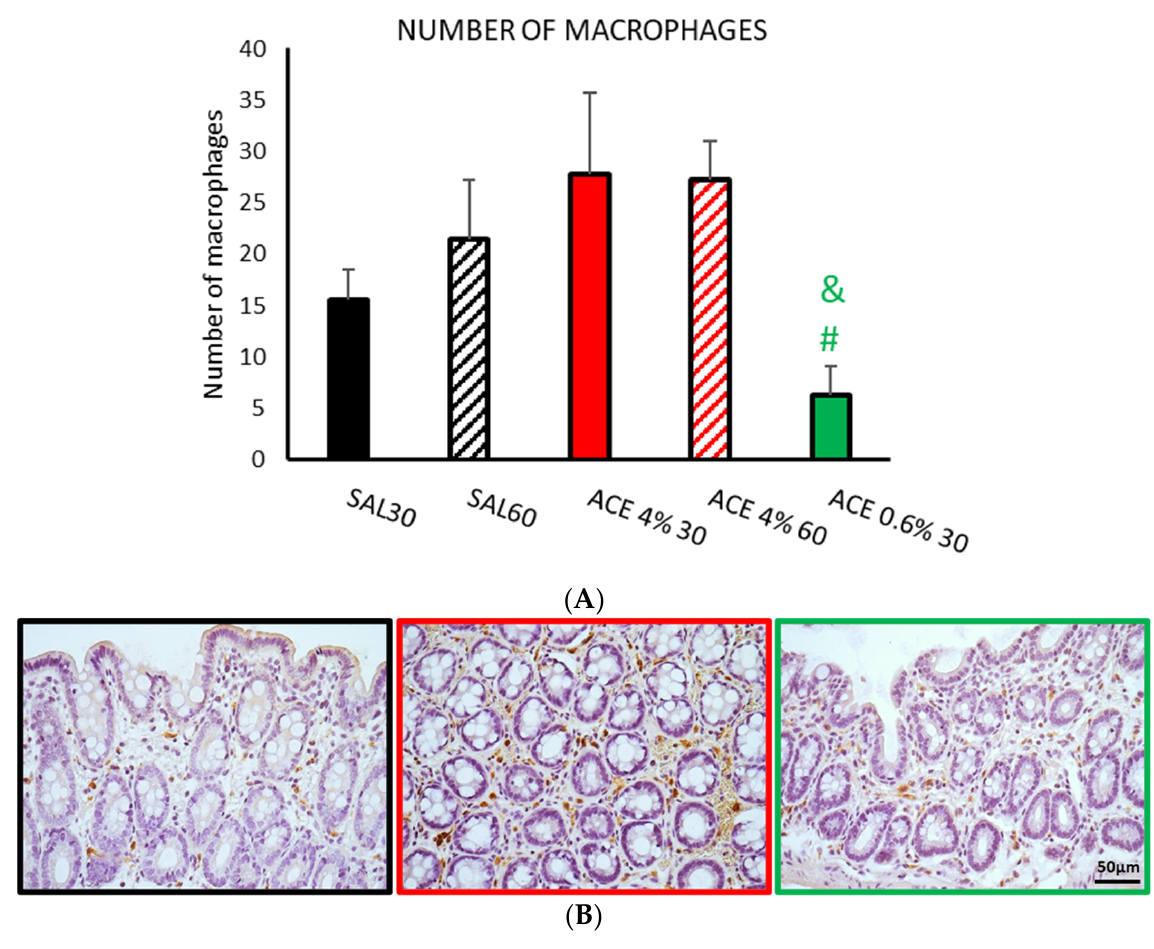
Figure 5. Effect of intracolonic administration of acetic acid on the number of macrophages, phase I (model selection). The number of macrophages ( A ) was assessed by immunohistochemistry in ten random fields per section. Experimental groups: SAL30, black bar; SAL60, black striped bar; ACE 4% 30, red bar; ACE 4% 60, red striped bar; ACE 0.6% 30, green bar. Data represent mean ± SEM. # p < 0.05 vs. ACE 4% 30; & p < 0.05 vs. ACE 4% 60. One-way ANOVA followed by Bonferroni post hoc test ( n = 8–13). ( B ) Photomicrographs of CD163 immunopositive cells (pro-inflammatory macrophages) in colonic mucosa after intracolonic administration of SAL30 (black frame), ACE 4% 30 (red frame), or ACE 0.6% 30 (green frame). Scale bar = 50 μm.